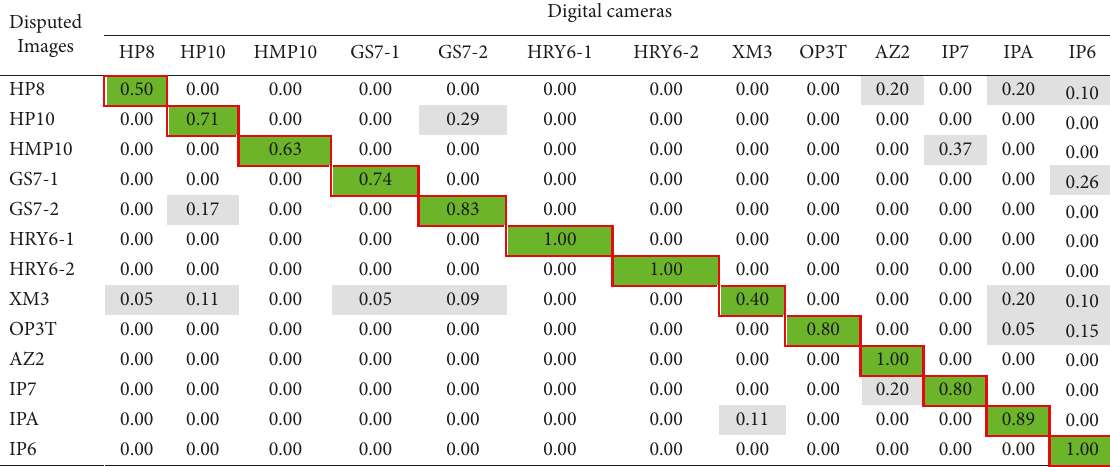
Table 2: Effectiveness of the method proposed by Quintanar-Res´endiz et al. [17] when it is applied to the first case study (reference and disputed images are flat images).